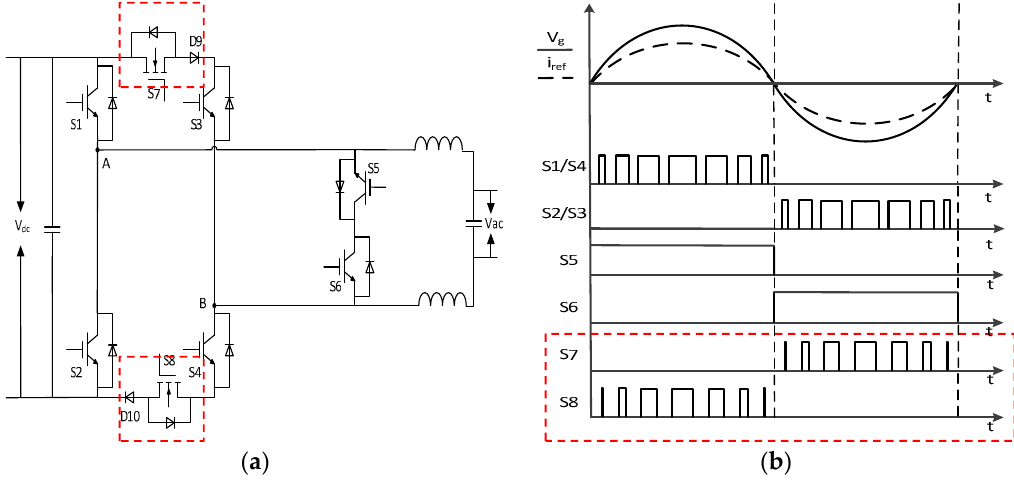
Figure 13. Improved HERIC inverter circuit and modulation with the hybrid switching method application ( a ) Improved HERIC inverter; ( b ) Improved modulation.